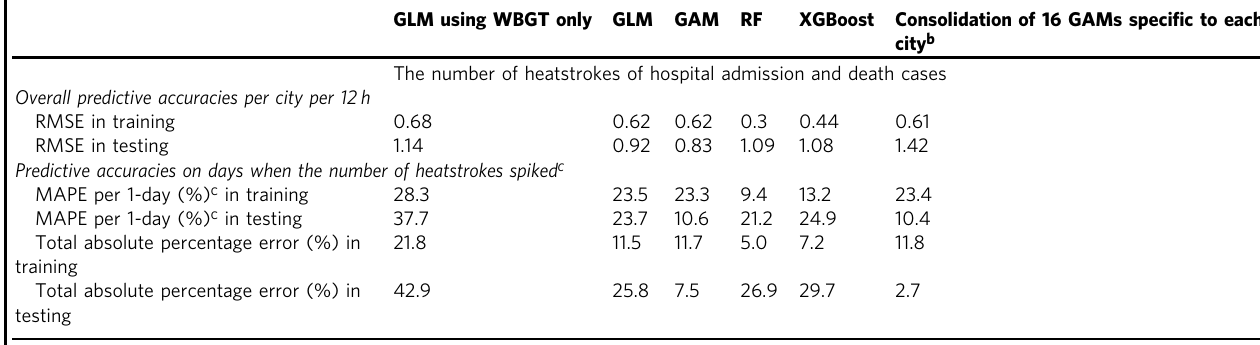
Table 4 Predictabilities of the prediction models for the number of heatstrokes of hospital admission and death cases among 6 models a .